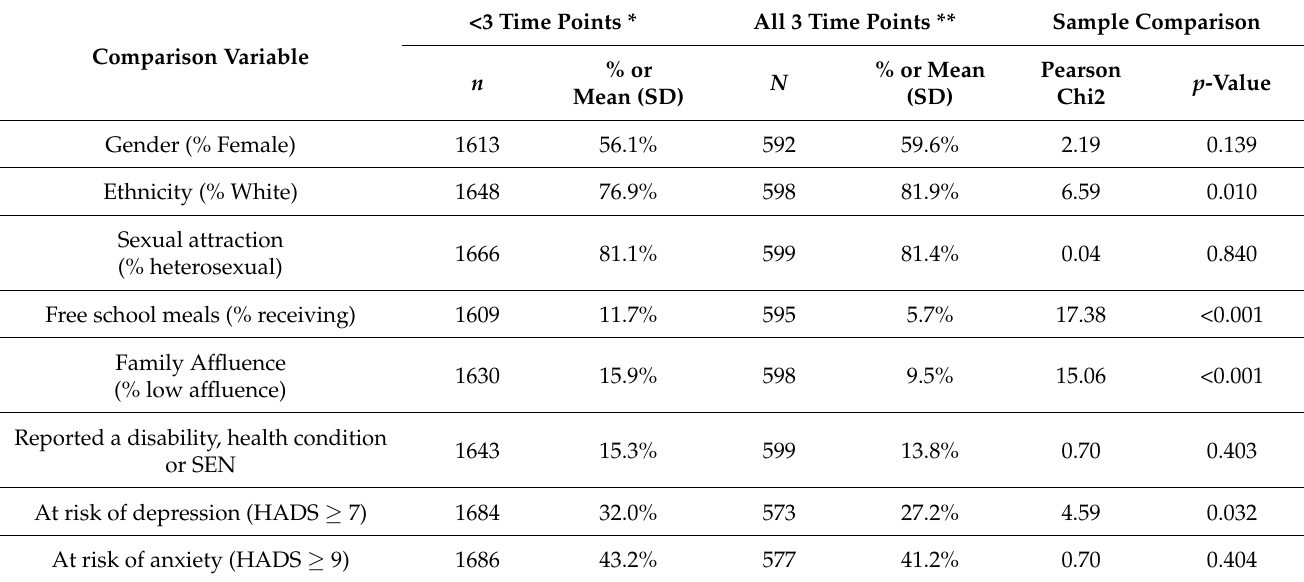
Table 1. Comparison of samples completing the survey at all three time points (analytic sample) and those with data available at fewer than three time